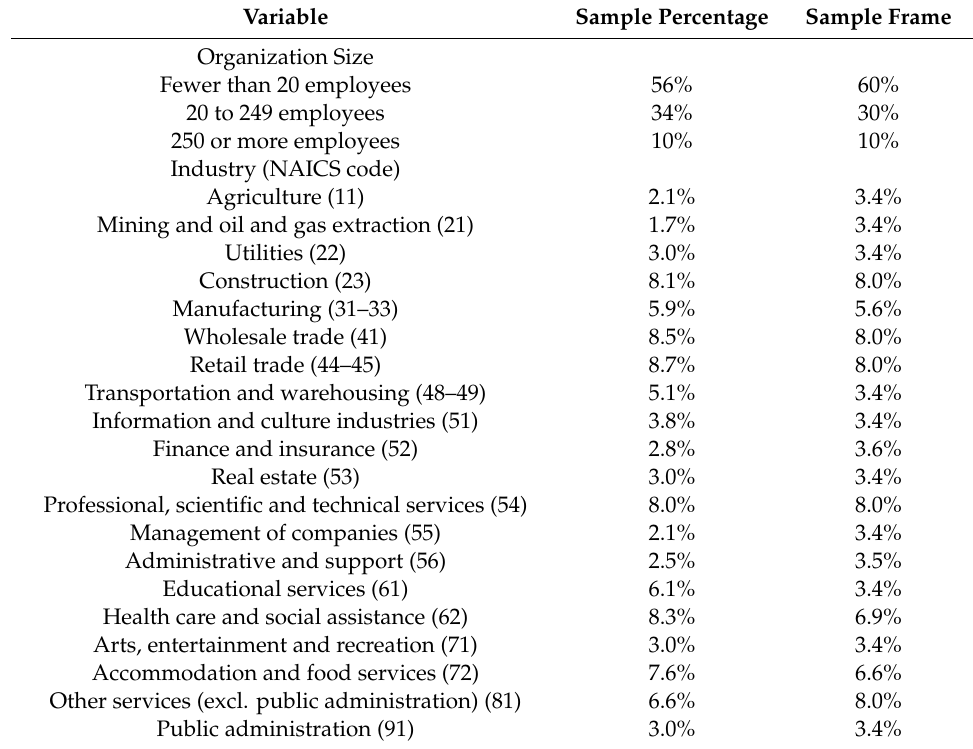
Table A3. Actual and Projected Sample Frame by Organization Size and Industry Type ( n =